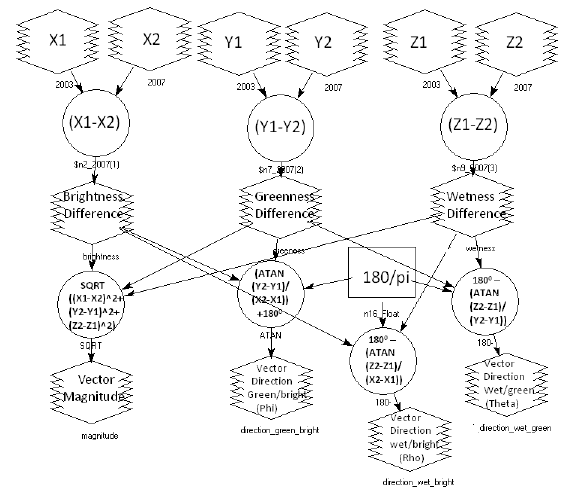
Figure 2. Graphical model script of the extended change vector analysis algorithm for SPOT 4 XS (2003) and SPOT 5 XS (2007)